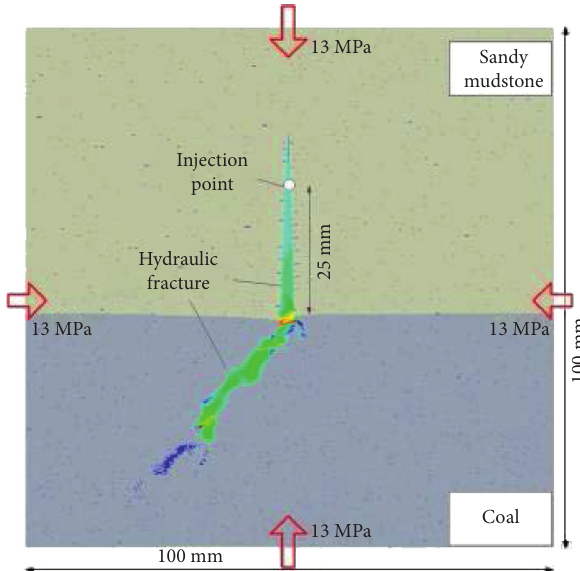
Figure 12: Hydraulic fracturing results obtained from 2D numerical